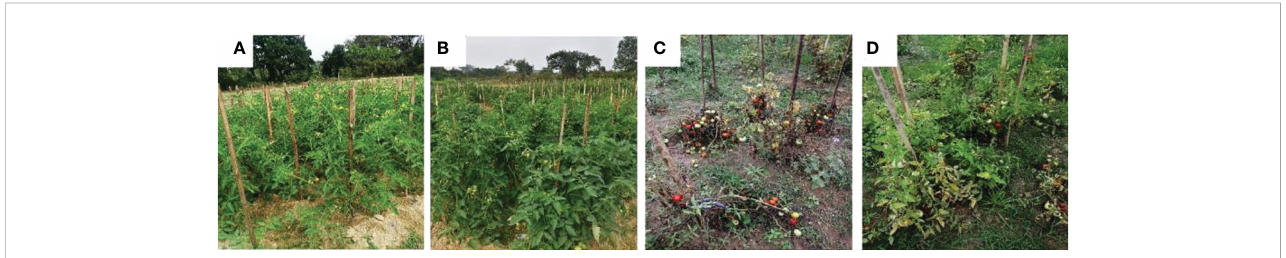
FIGURE 11 Biocontrol of bacterial wilt of tomato under fi eld conditions using Trichoderma harzianum MC2 and Trichoderma harzianum NBG. (A) (T1) = Untreated control (C) (T5) = plants inoculated with Ralstonia solanacearum (B) (T2) = plants treated with both bioagents Trichoderma harzianum MC2 + Trichoderma harzianum NBG (D) (T8) = plants treated with Trichoderma harzianum MC2 + Trichoderma harzianum NBG and challenged with Ralstonia solanacearum .